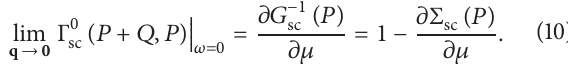
Figure 3: Spin interaction vertex. It has different signs for different pseudospin